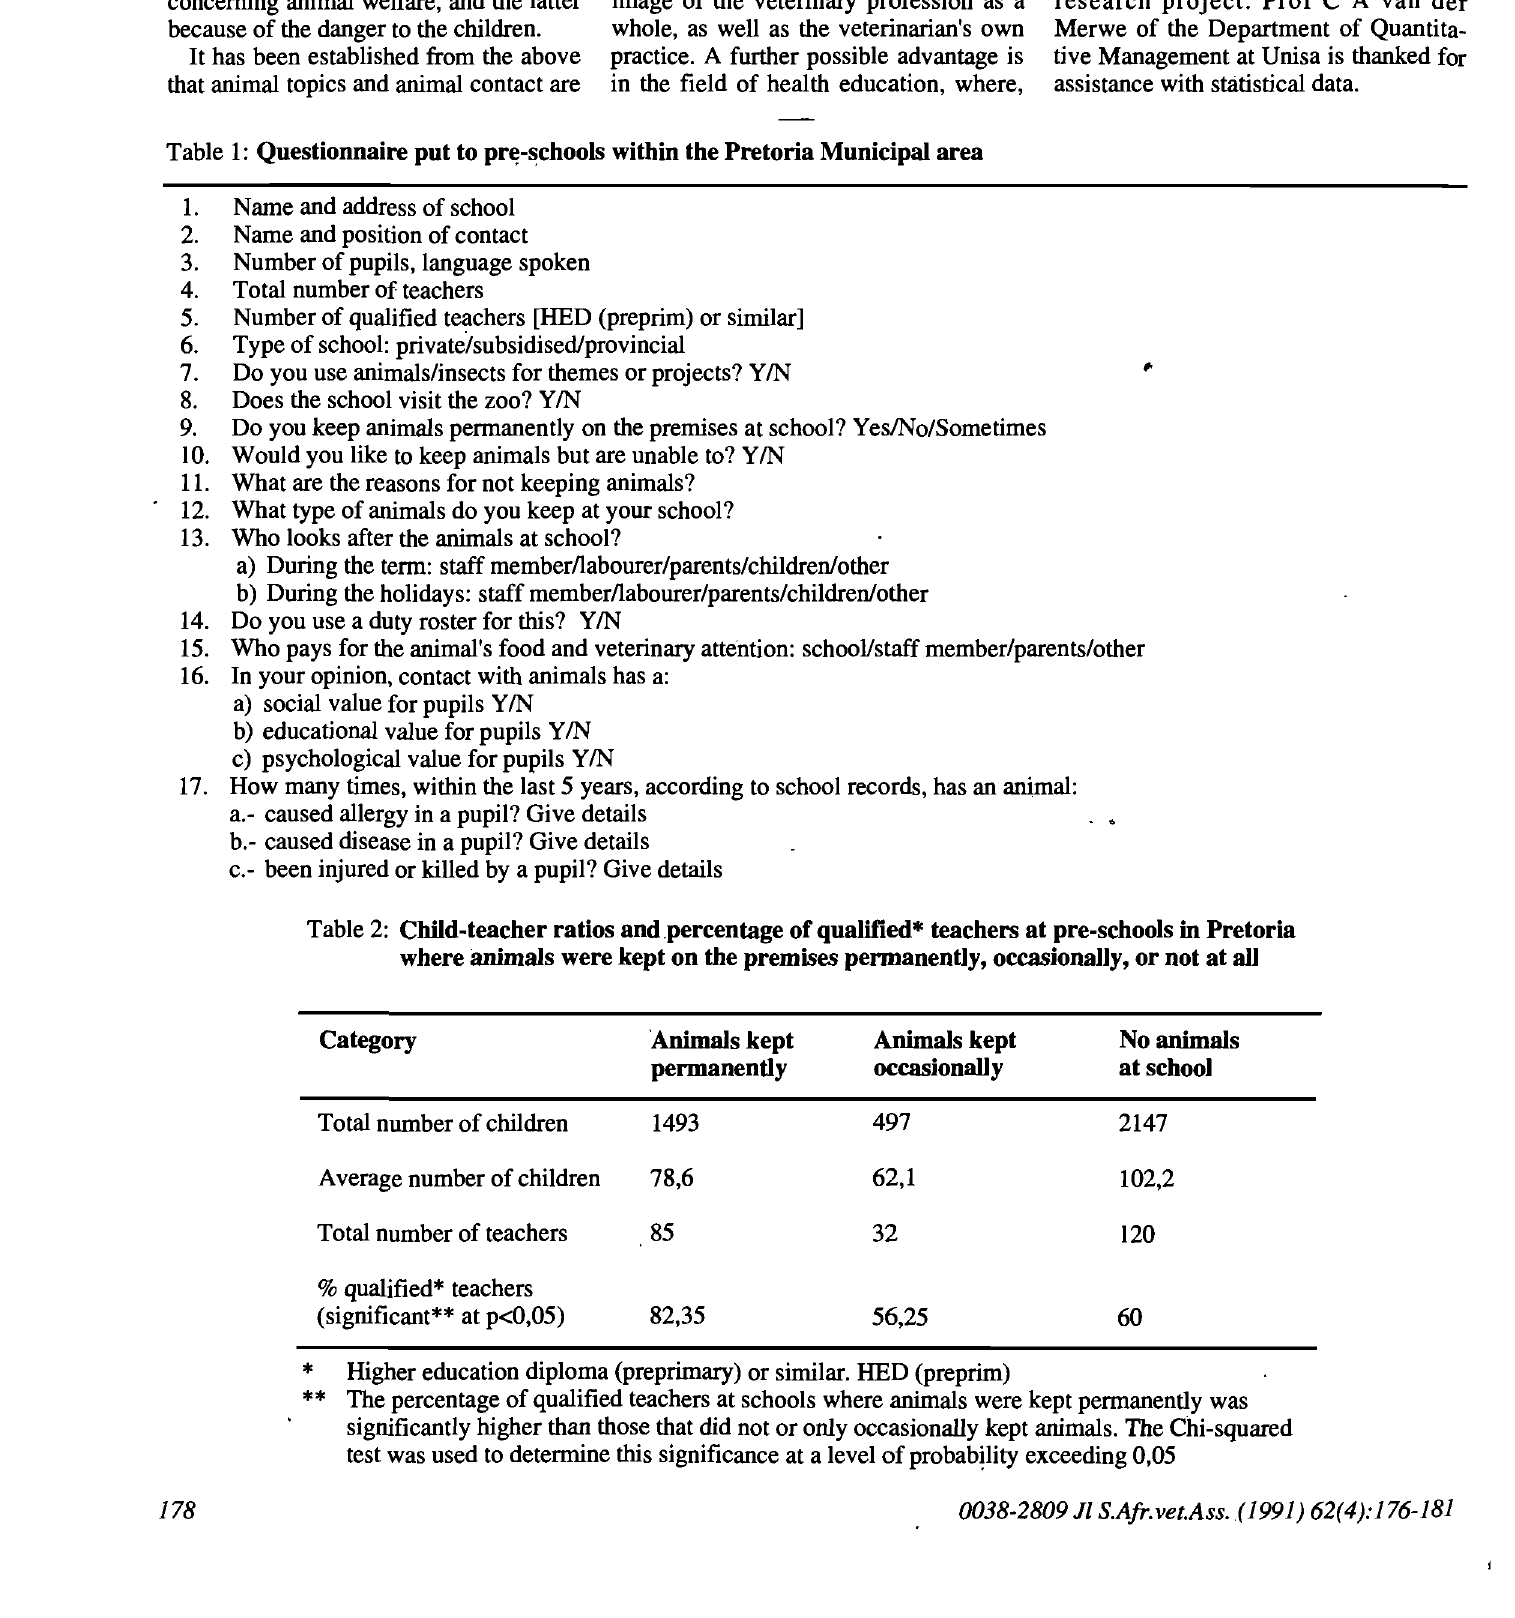
Table 1: Questionnaire put to pr~-schools within the Pretoria Municipal area